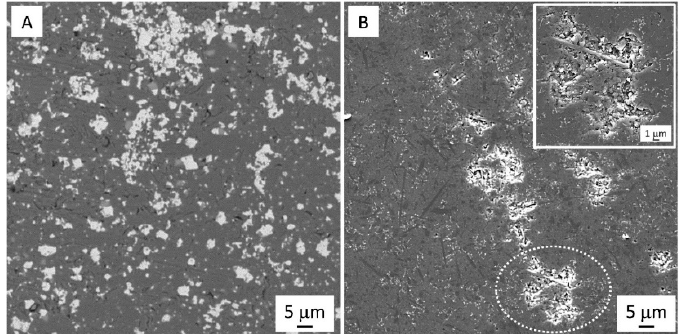
Figure 10. Scanning electron microscope photos of the friction surface of ( A ) α - β 20T and ( B ) TC3030 ceramics. The dotted line indicates the area where the close-up was taken.